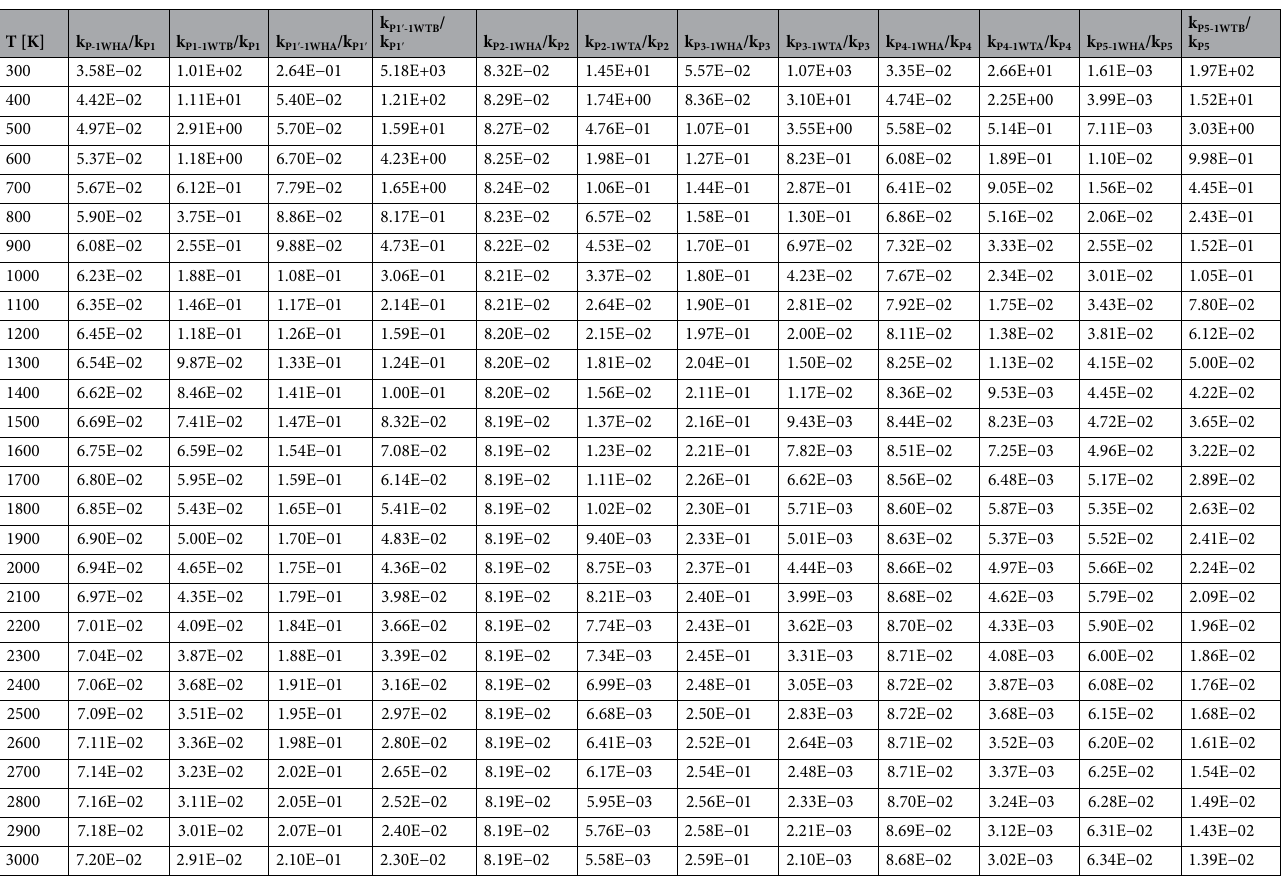
Table 6. The ratios of the computed rate constants at the BD(T) level for the water-assisted paths to the respective ones in the bare